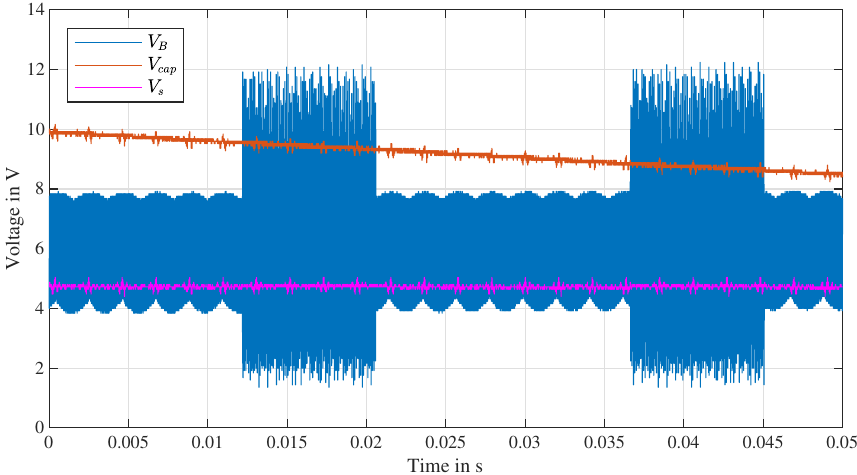
Figure 14. Voltages across the capacitor C s ( V cap ), at node B ( V B ) and the signal V s measured on our